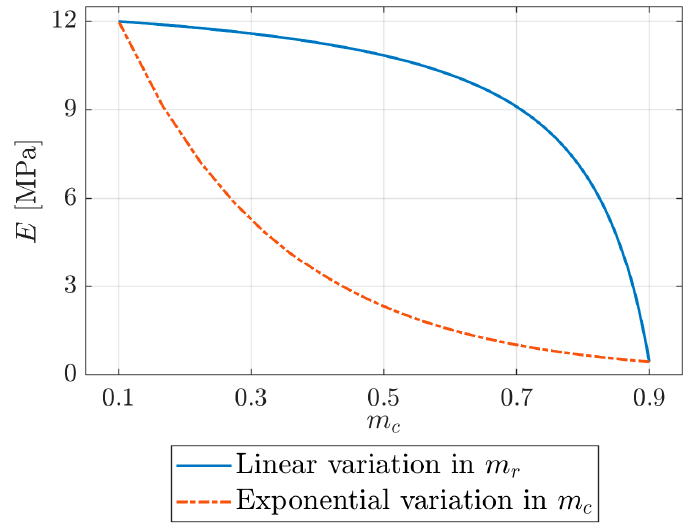
Figure 6. Development of the elastic modulus E with moisture content m c for the two tested cases. The second part of the parameter study examined the effect of changing the cohesive law. Changing the softening behaviour, while keeping the fitting parameters constant, allowed for studying its impact on the solution (see Figure 4c for an example of different softening behaviours). Replacing the linear softening as defined in Equation (15) with an exponential gives the damage variable as